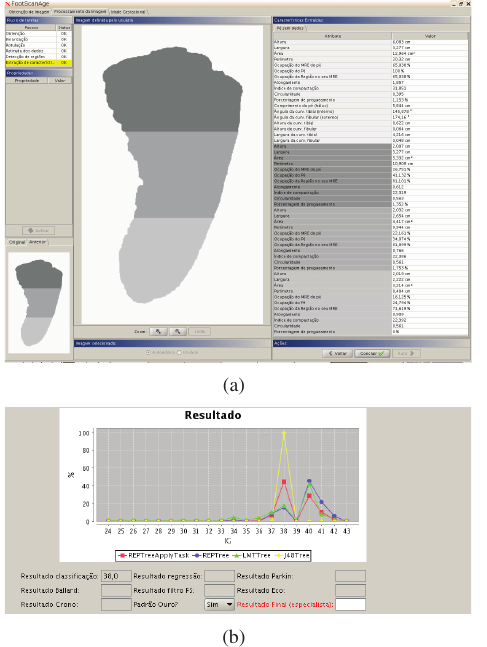
Fig. 8. FootScanAge: (a) feature extraction step on the IPT module and (b) the final result of the DMT